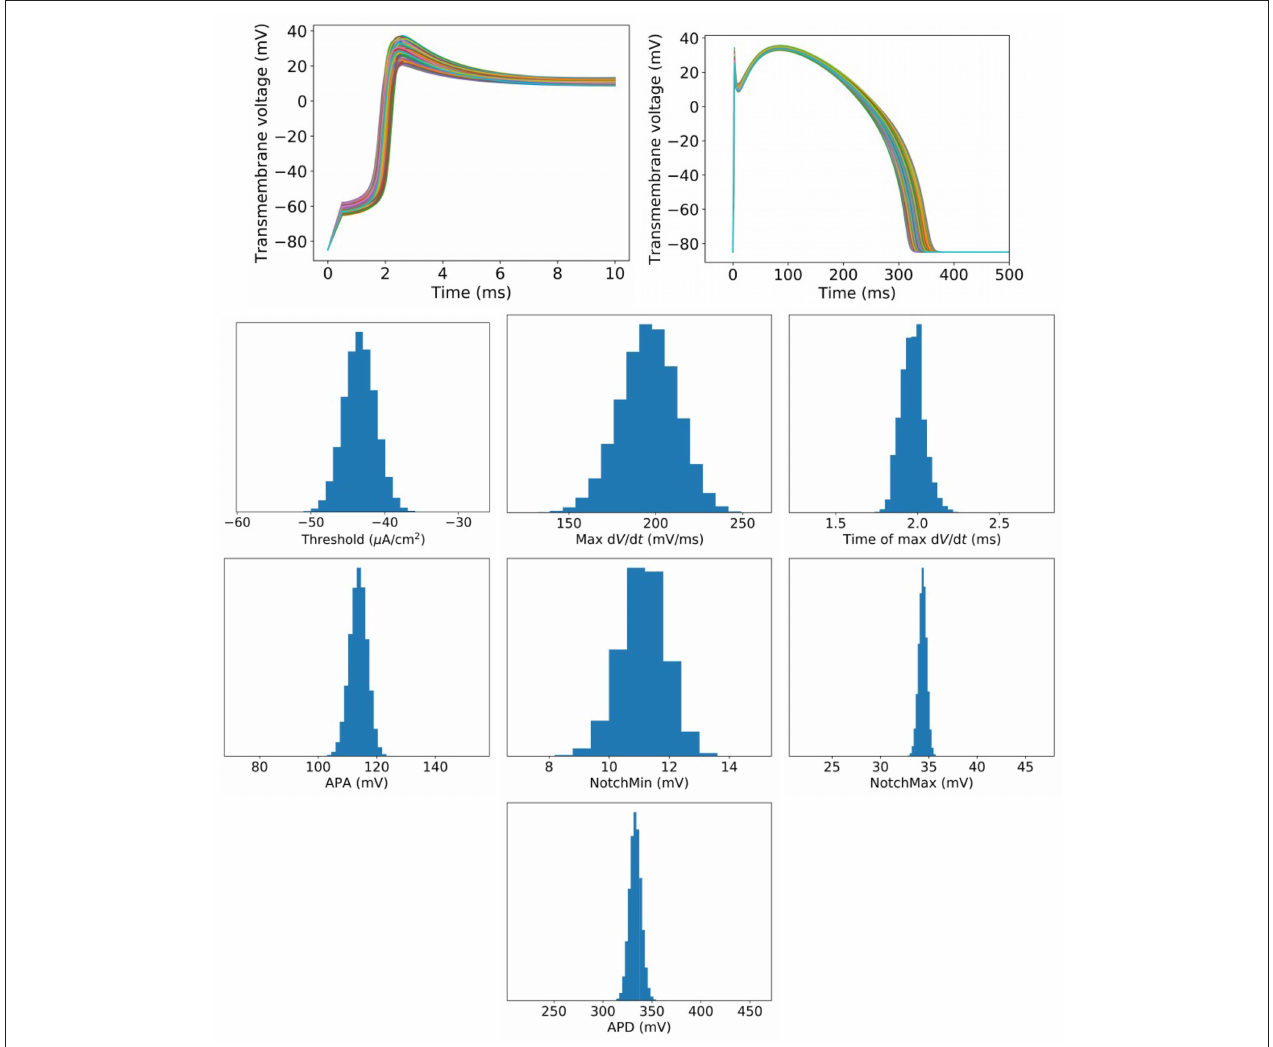
FIGURE 3 | Results for ˆ σ = 1 % , which represents a small amount of uncertainty in all cell model parameters. Top : Upstrokes and full action potentials for 1,000 randomly sampled parameters. Below : converged histograms for various quantities of